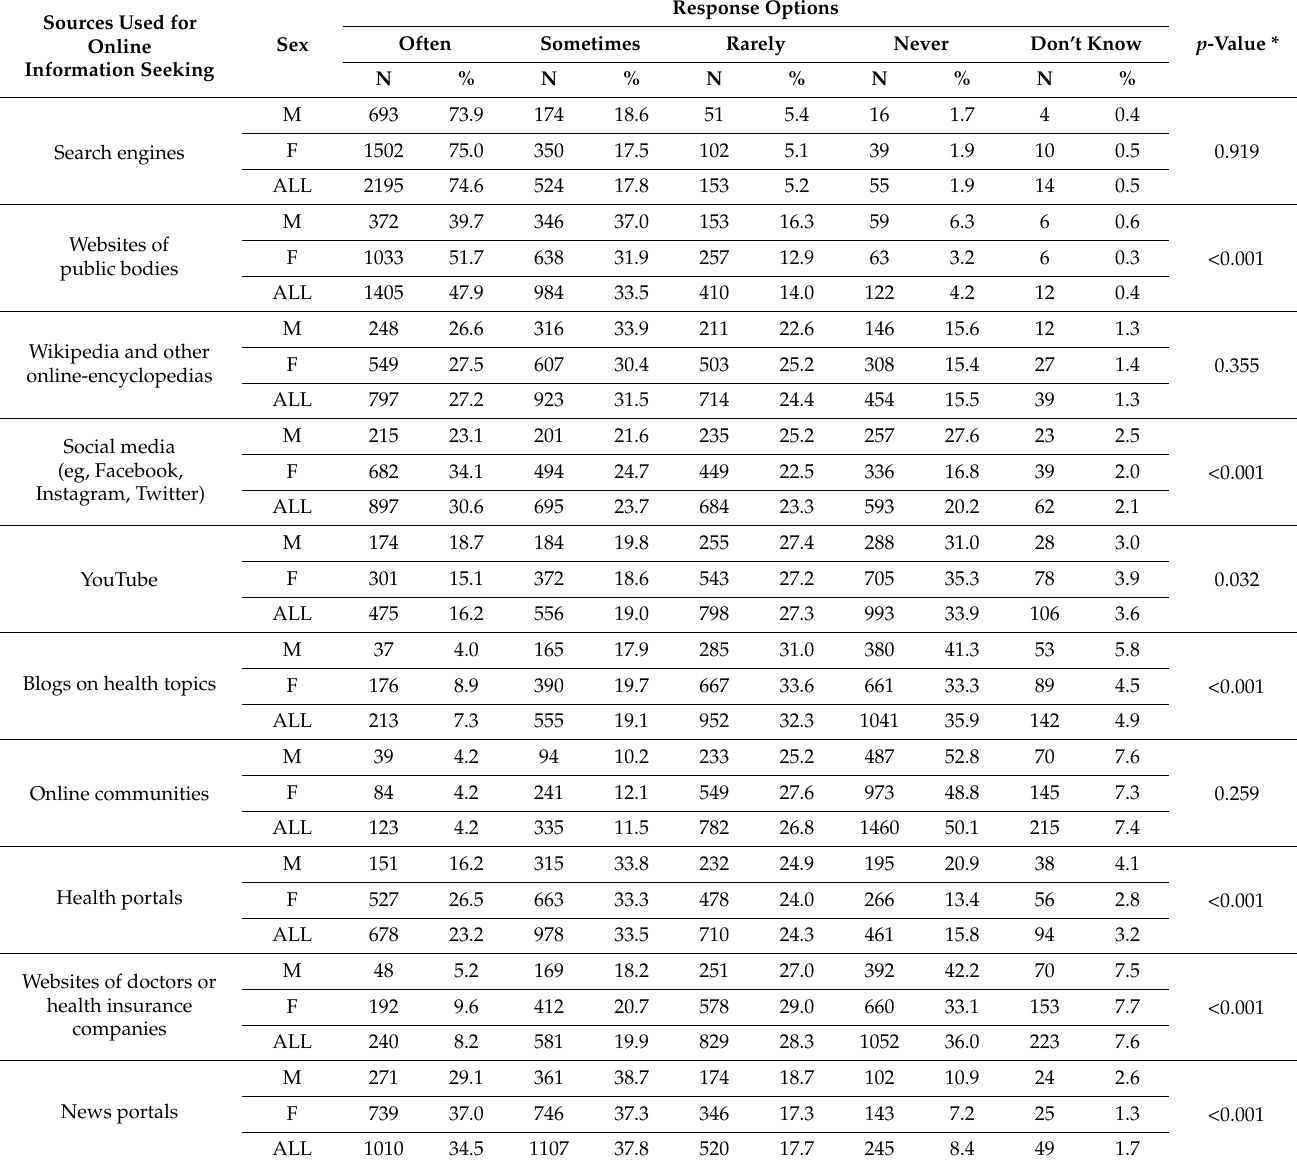
Table 1. Descriptive analysis of the sources used for online information seeking ( N =